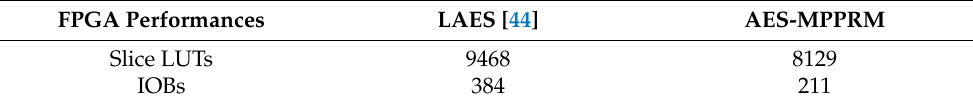
Table 7. Comparison of AES-MPPRM and LAES for Kintex 7 FPGA.